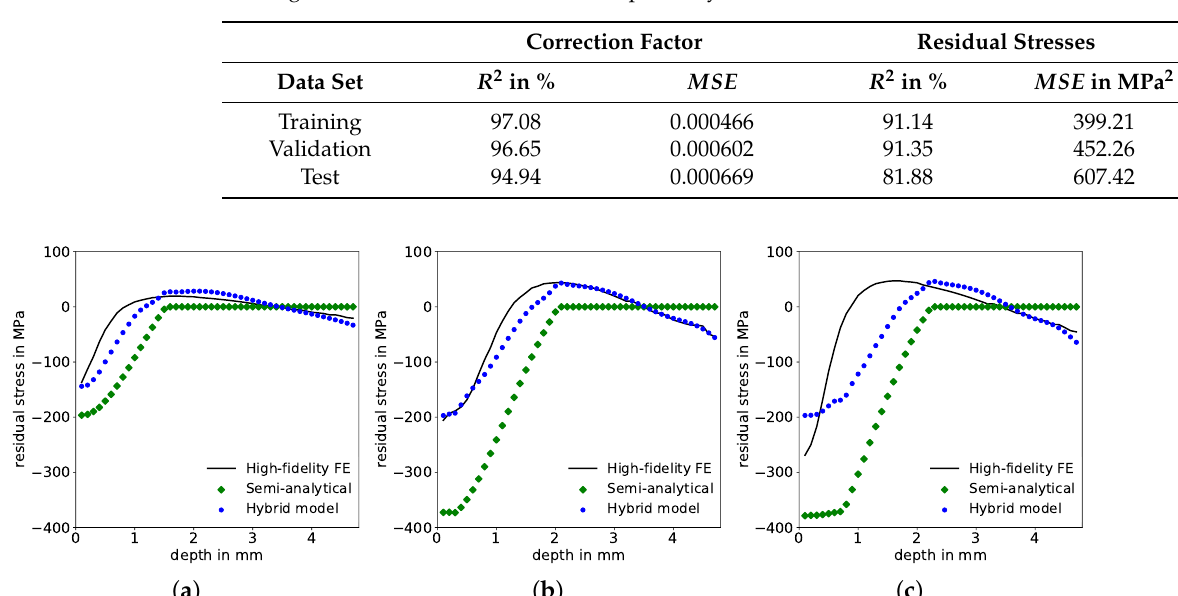
Figure 6. ( a ) Learning curves: Mean squared error (MSE)-loss function values minimized via weight adjustment of the ANN on training set and simultaneous MSE for predictions on validation set with training-set weights over number of epochs during training. ( b ) Determination coefficient R 2 for correction factor (ANN output) achieved by ANN on training, validation and test data sets. ( c ) Determination coefficient R 2 for related residual stresses attained by ANN on training, validation and test data sets. Table 3. Prediction metrics of trained ANN via Approach 1: R 2 (determination coefficient) and MSE (mean squared error) for correction coefficients as well as for corresponding residual stresses on training, validation and test data sets, respectively.